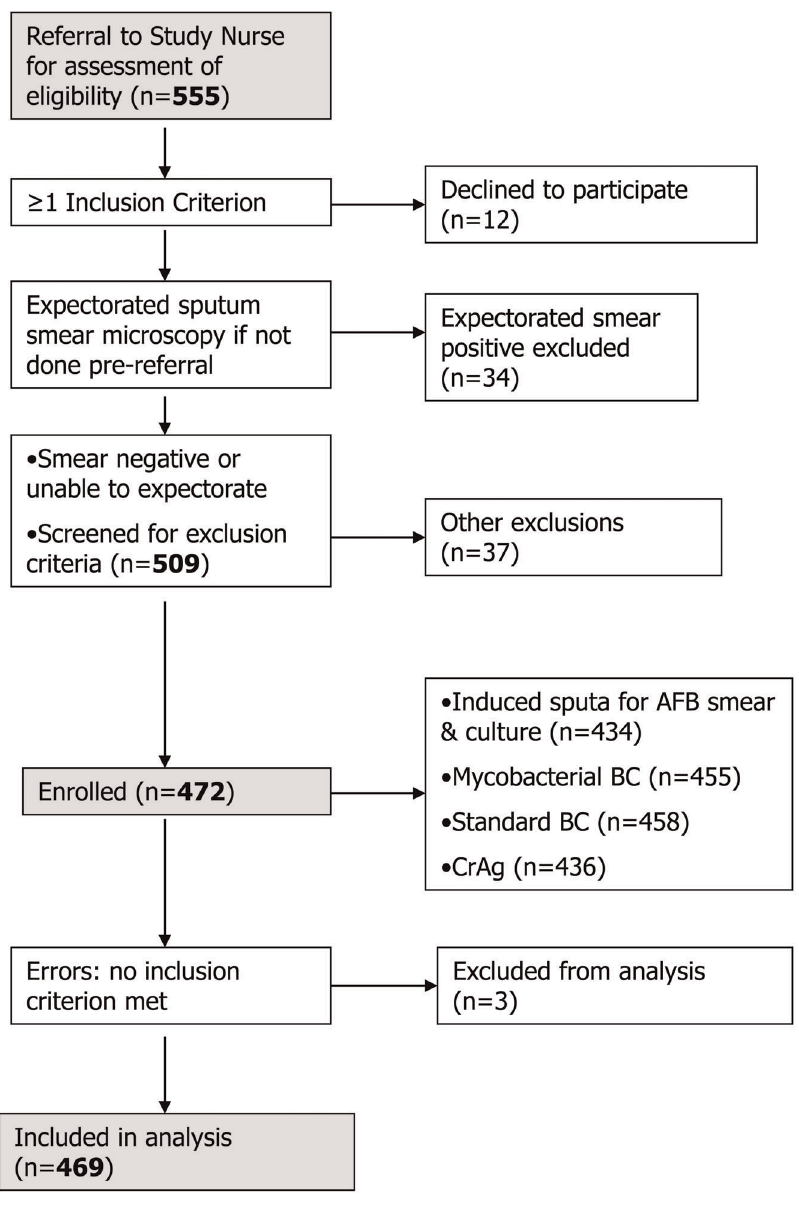
Figure 1. Study Enrolment Flowchart.